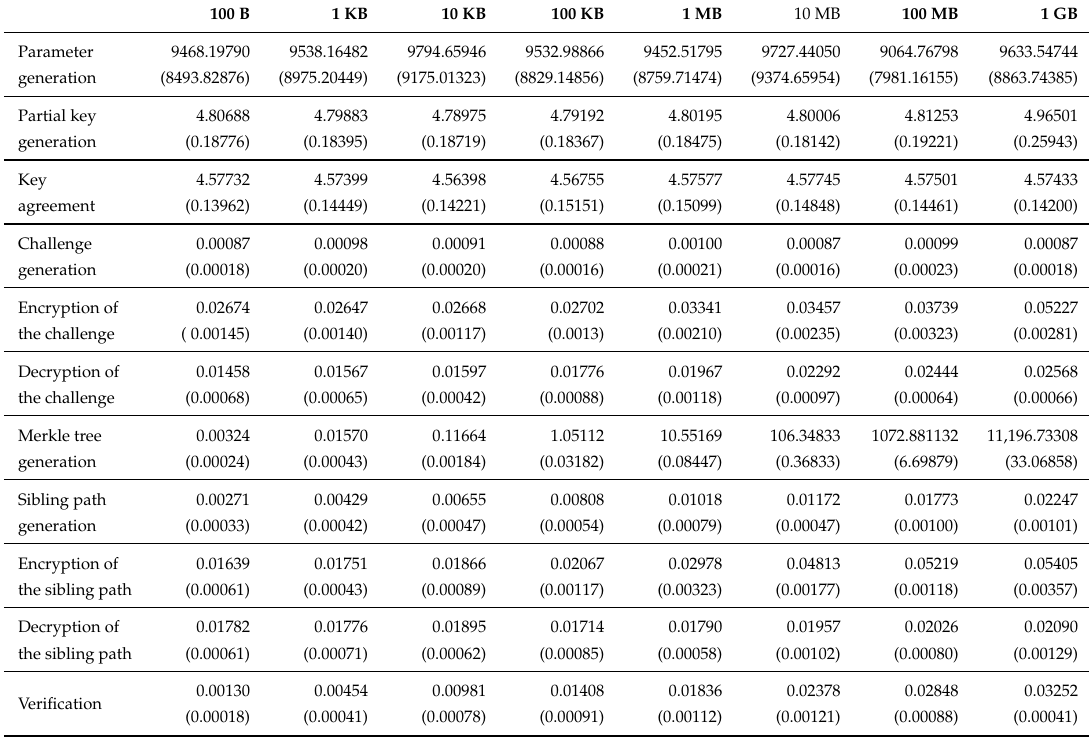
Table 4. Average computation time (ms) for Merkle tree-based encrypted authentication by data size (standard deviation in